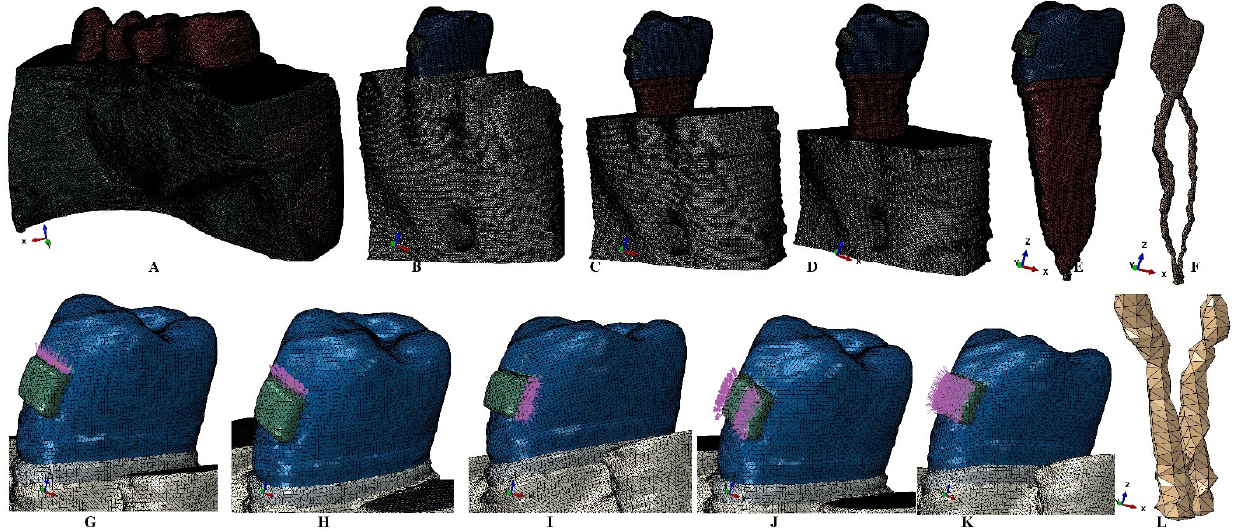
Figure 1. FEA mesh: ( A )—one of the nine complete models (320 × 320 × 320 mm), ( B )—2nd lower right premolar model (26 mm height) with intact periodontium, ( C )—4 mm loss bone loss, ( D )—8 mm bone loss, ( E )—premolar (26 mm height) with NVB and bracket, ( F )—dental pulp and NVB, orthodontic loads vectors: ( G )—intrusion, ( H )—extrusion, ( I )—translation, ( J )—rotation, ( K )—tipping, ( L )—NVB and apical third dental pulp.